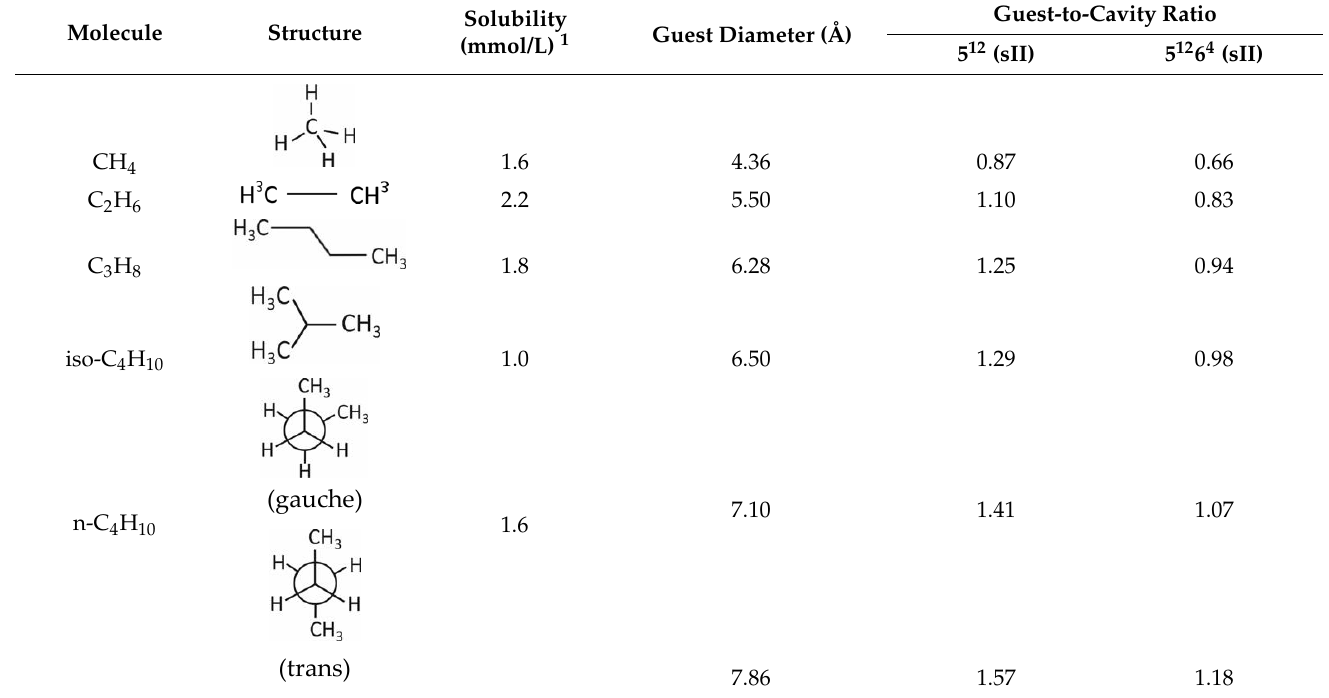
Table 3. Properties of guest molecules as well as the guest-to-cavity ratio of each component in the sII hydrate. Except for the solubility data from Air Liquide Germany GmbH, all the other data were from Sloan and Koh, 2008 [2]. Molecule